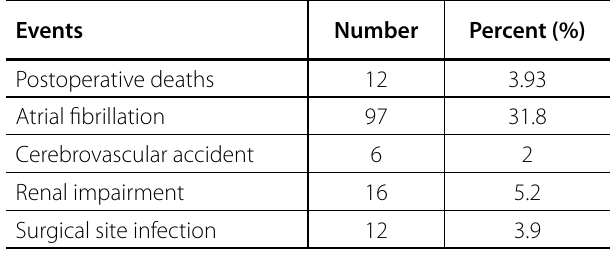
Table 2. Postoperative morbidity and mortality (all patients